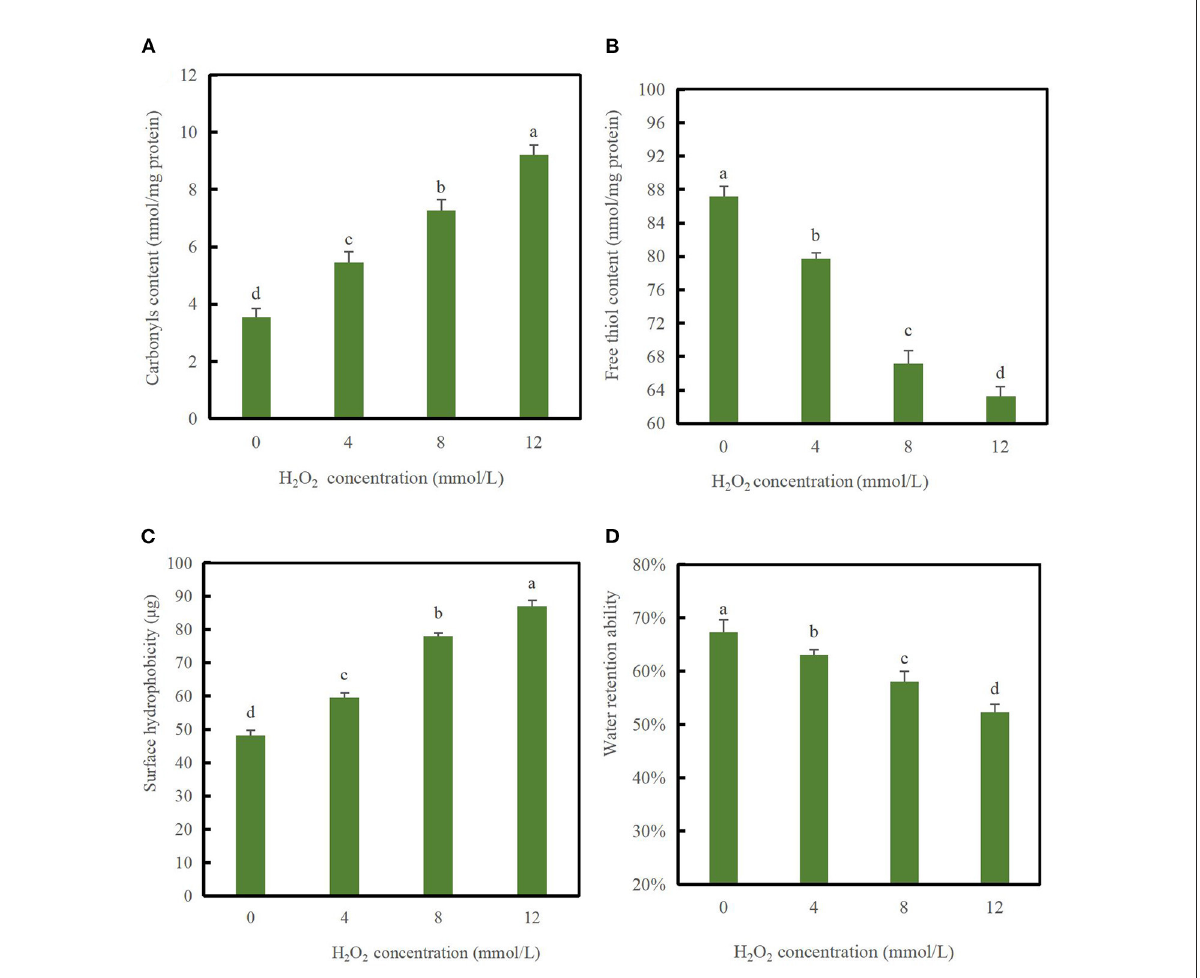
FIGURE1 Changes in carbonyl values (A) , free thiol content (B) , surface hydrophobicity (C) , and water retention ability (D) of duck myofibrillar proteins (DMPs) treated with various hydroxyl radical levels (H 2 O 2 concentrations: 0, 4, 8, 12 mmol/L). Different lowercase letters (a–d) indicate significant differences between the treated and control groups ( p <